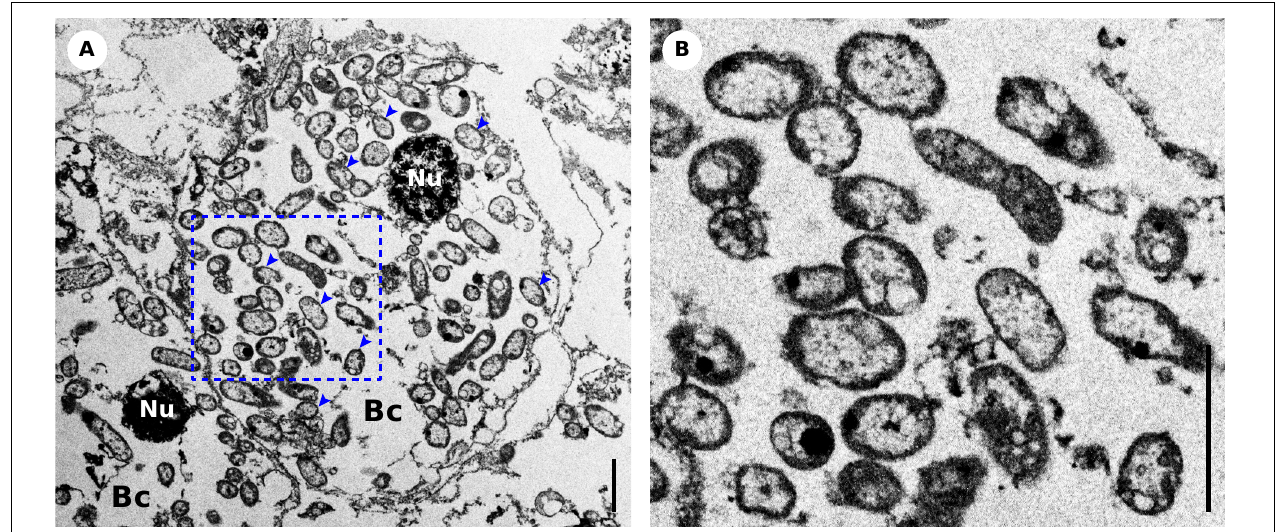
FIGURE 9 | Morphological features of the Sclerolinum annulatus n. sp. endosymbionts. (A) Transmission electron microscopy (TEM) of the trunk region, showing the endosymbionts inside the bacteriocytes are rod or coccus in shape without internal stacked membranes (indicated by blue arrows). (B) TEM of a close-up section of the endosymbionts within the blue dotted box in (A) . Scale bars: (A,B) 2 µ m. Bc, bacteriocyte; Nu, nucleus.